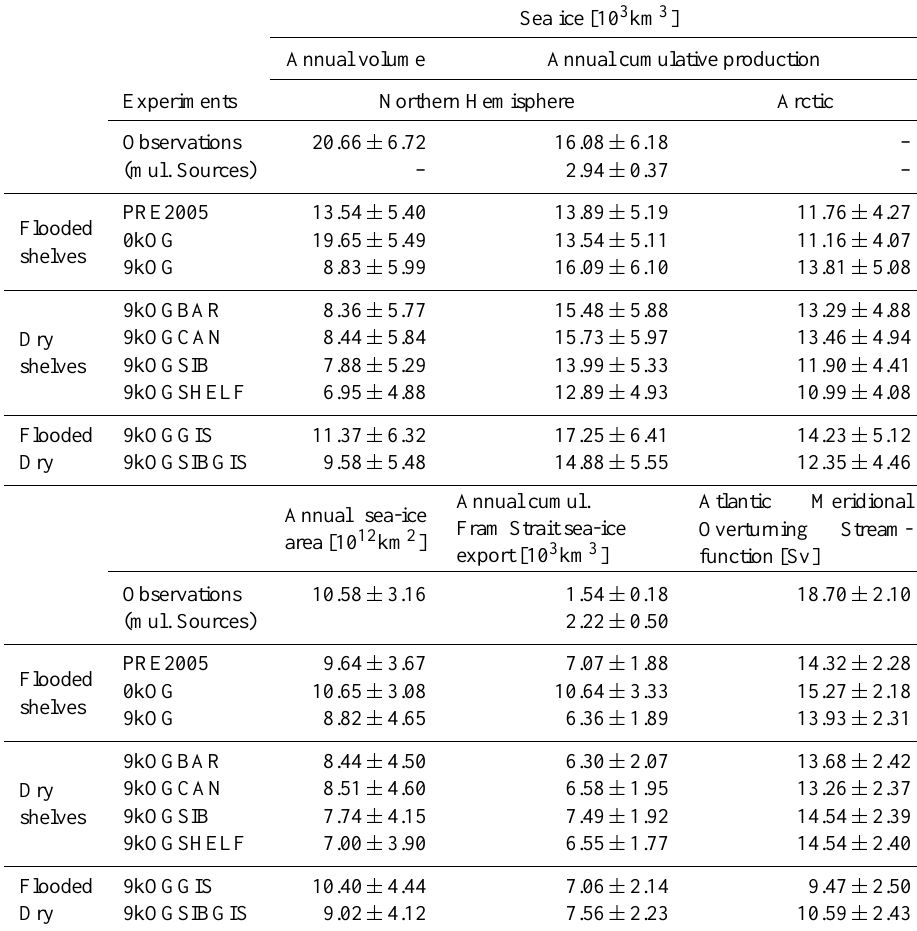
Table 2. Summary of annual mean and standard deviation of sea-ice parameters in nine different model simulations. Northern Hemisphere sea-ice volume in km 3 . Northern Hemisphere and Arctic annual cumulative sea-ice production (0–360 ◦ E and 40–90 ◦ N, 20–280 ◦ E and 65– 90 ◦ N) in km 3 . Northern Hemisphere annual mean sea-ice area in 10 12 km 2 . Annual cumulative Fram Strait sea-ice export in km 3 . Meridional overturning strength in the North Atlantic (AMOC) at 27 ◦ N in Sv. All values are calculated from the last 100yr of the simulations except for PRE2005 over 1976 to 2005 as Fig. 2. The corresponding data source for Northern Hemisphere sea-ice volume is the PIOMAS data from Zhang and Rothrock (2003). For Northern Hemisphere annual cumulative sea-ice production there are two estimates, the first one derived from Zhang and Rothrock (2003) and the second one from Tamura and Ohshima (2011), the latter denoting only polynya-based sea-ice production. Northern Hemisphere sea-ice area is taken from HadISST data (Rayner et al., 2003). Fram Strait sea-ice export estimates are taken from Spreen et al. (2009) (1st) and Kwok et al. (2004) (2nd). Recent estimates of the AMOC strength have been published by Kanzow et al.